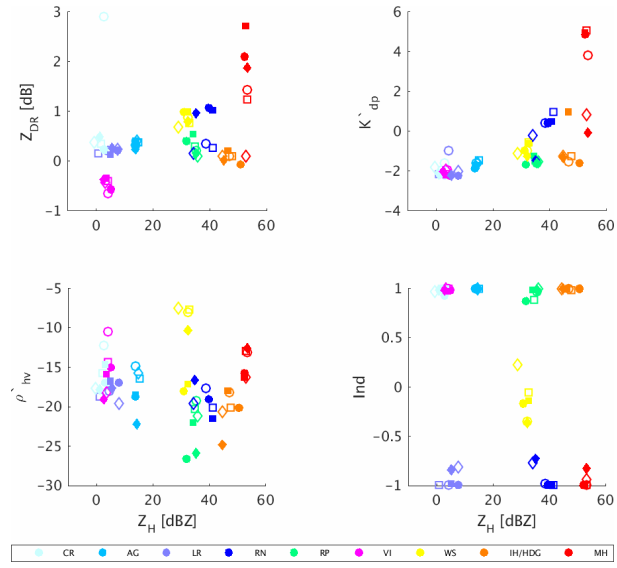
Figure 6. Centroids for Albis ( ◦ ), Monte Lema ( (cid:3) ) and Plaine Morte ( ) radars: before (empty) and after (filled) attenuation and noise corrections. Classes: CR is crystals, AG is aggregates, LR (cid:51) is light rain, RN is rain, RP is rimed ice particles, VI is vertically aligned ice, WS is wet snow, IH/HDG is ice hail and high density graupel and MH is melting hail. K (cid:48) and ρ (cid:48) are defined in Eqs. (7) dp hv and (8)